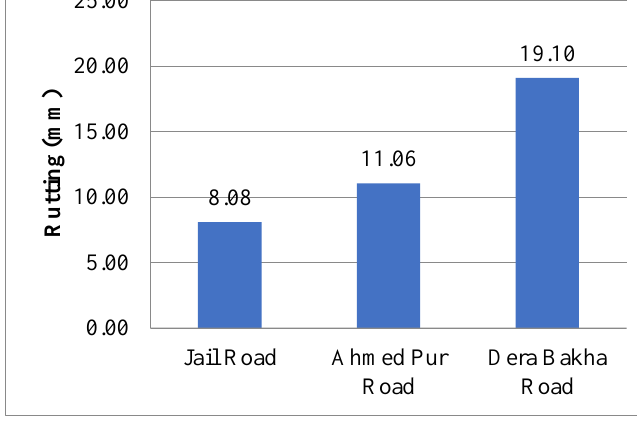
Fig. 2. Rutting values (mm)